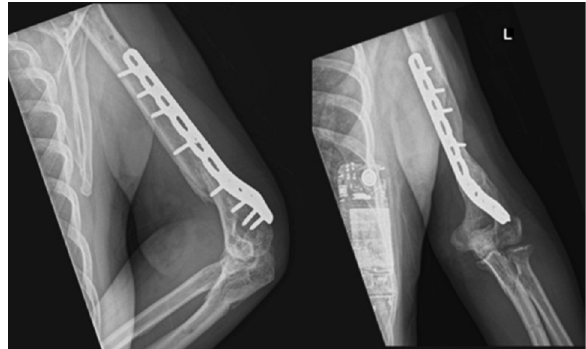
Definitive fixation with an extra-articular distal humerus Fig. 3: locking plate, healed at three